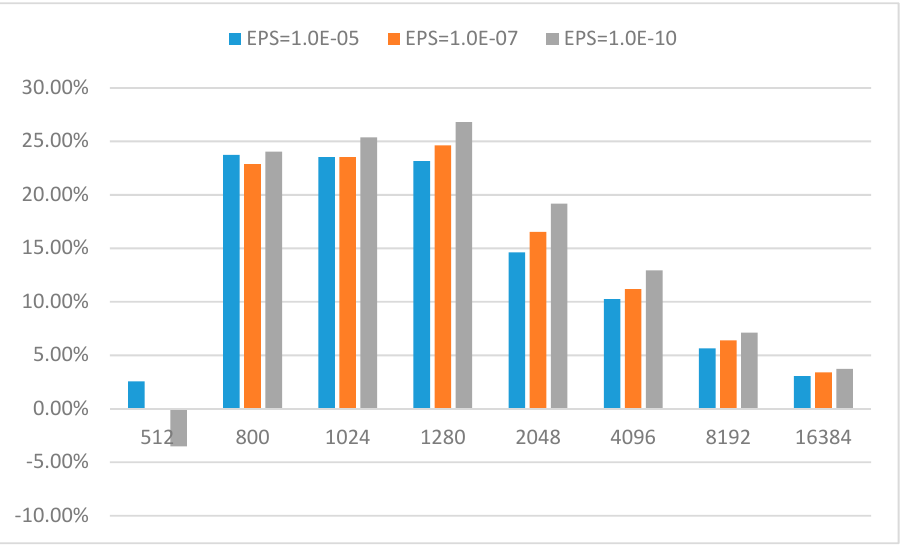
Figure 7. Loss speedup of LT2 with CMAX = 64 compare to LT1 (LT1 is the butterfly algorithm and LT2 is the proposed method, EPS is desired precision in interpolative decomposition, CMAX is the number of columns in each sub-matrix on level 0).